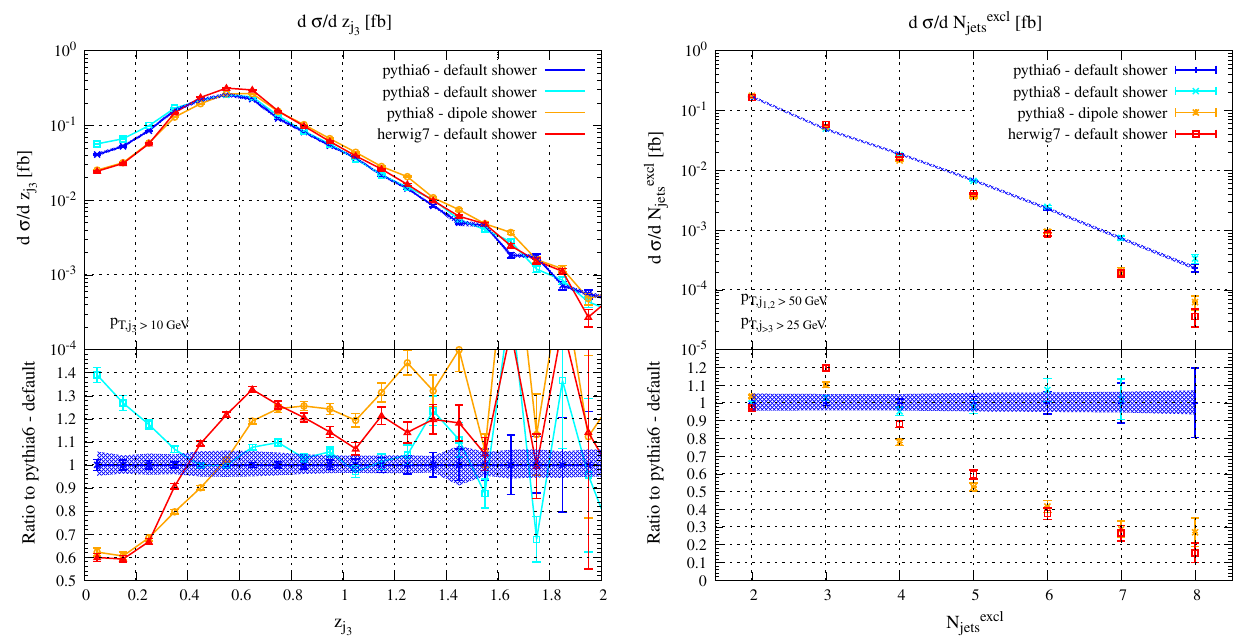
Fig. 3 Transverse-momentum (left) and rapidity (right) distributions of the third jet in the CMS-tight scenario. In the lower panels the ratio of the respective distribution to the PYTHIA6 reference result is shown. In